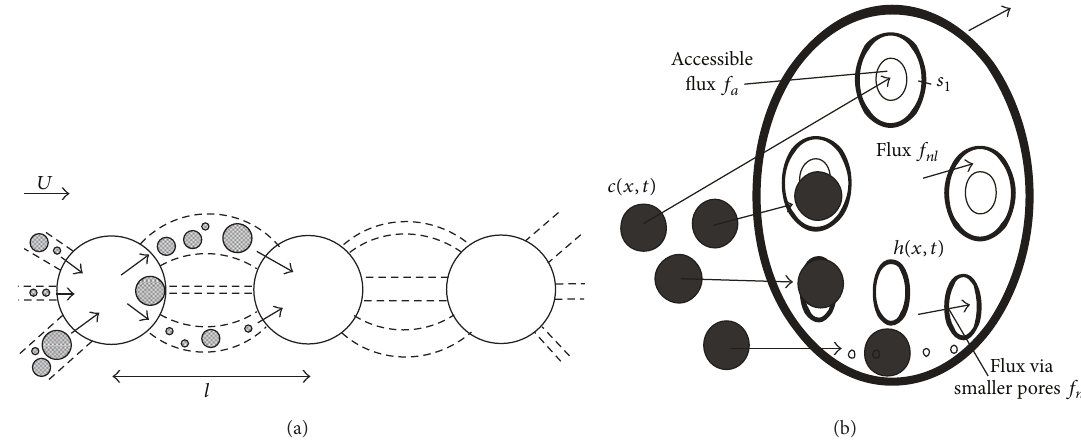
Figure 1: Geometric model of parallel capillary bundles with mixing chambers: (a) bundles of parallel capillaries alternated by mixing chambers; (b) cross section of the capillary bungle with size-excluded